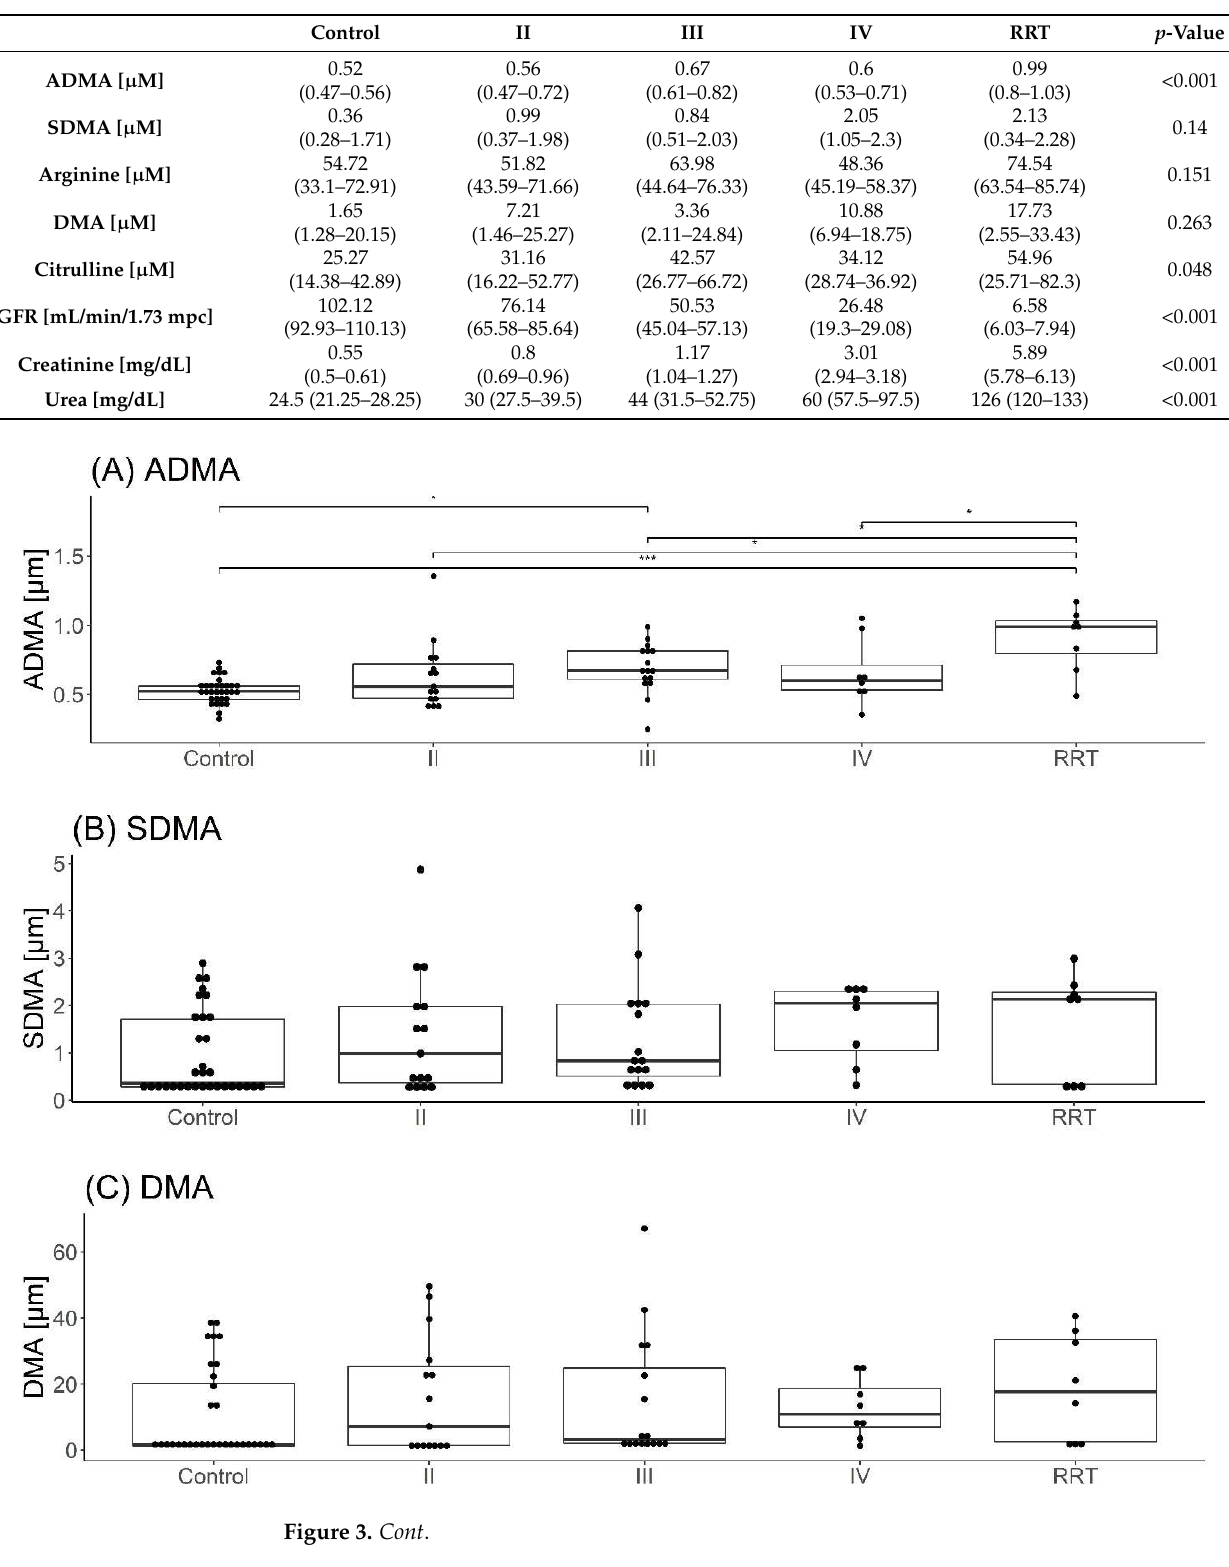
Table 3. Values of measured NO synthesis metabolites parameters for individuals with different stages of CKD and Control group. p -value is for the difference in distribution between groups. A comparison was performed using Kruskal–Wallis test.